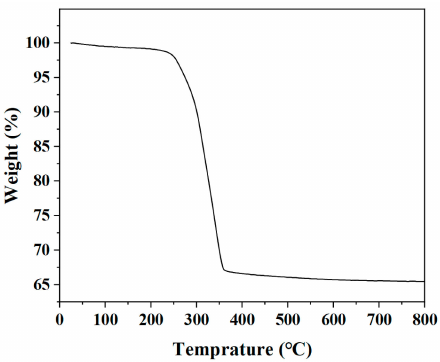
Figure 1. TG curve of the precursors of In 2 O 3 hollow